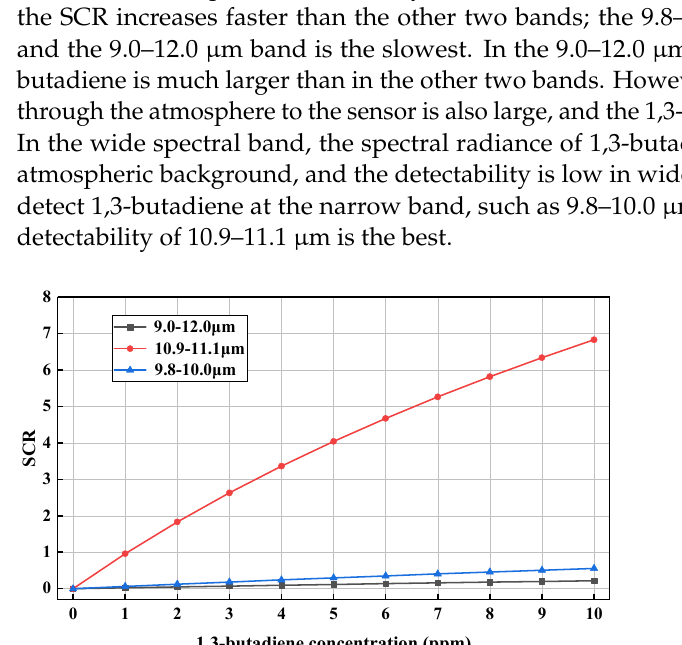
Figure 6. ( a ) The at-detector radiance of 9.0–12.0 μ m for 1,3-butadiene concentrations (0–10 ppm), ( b ) the difference between the radiance of 0 ppm 1,3-butadiene, and the other 1,3-butadiene concen- trations (1–10 ppm).